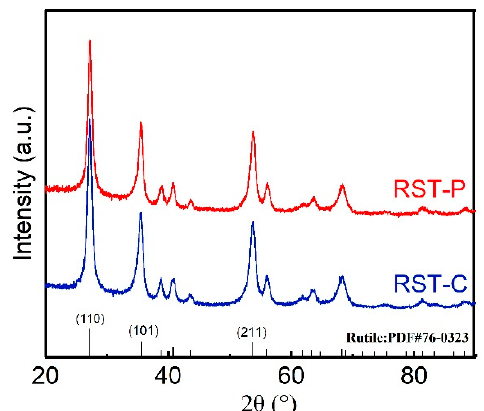
Figure 2. XRD spectra of the RST catalysts. The peak information for different crystal planes of rutile TiO 2 (No. 76-0323) is presented in figure. Table 2. Rietveld refinement of the XRD patterns.